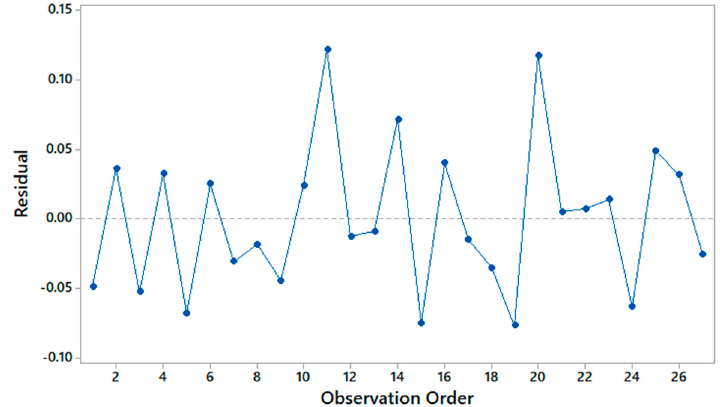
Figure 8. Residuals according to observations.